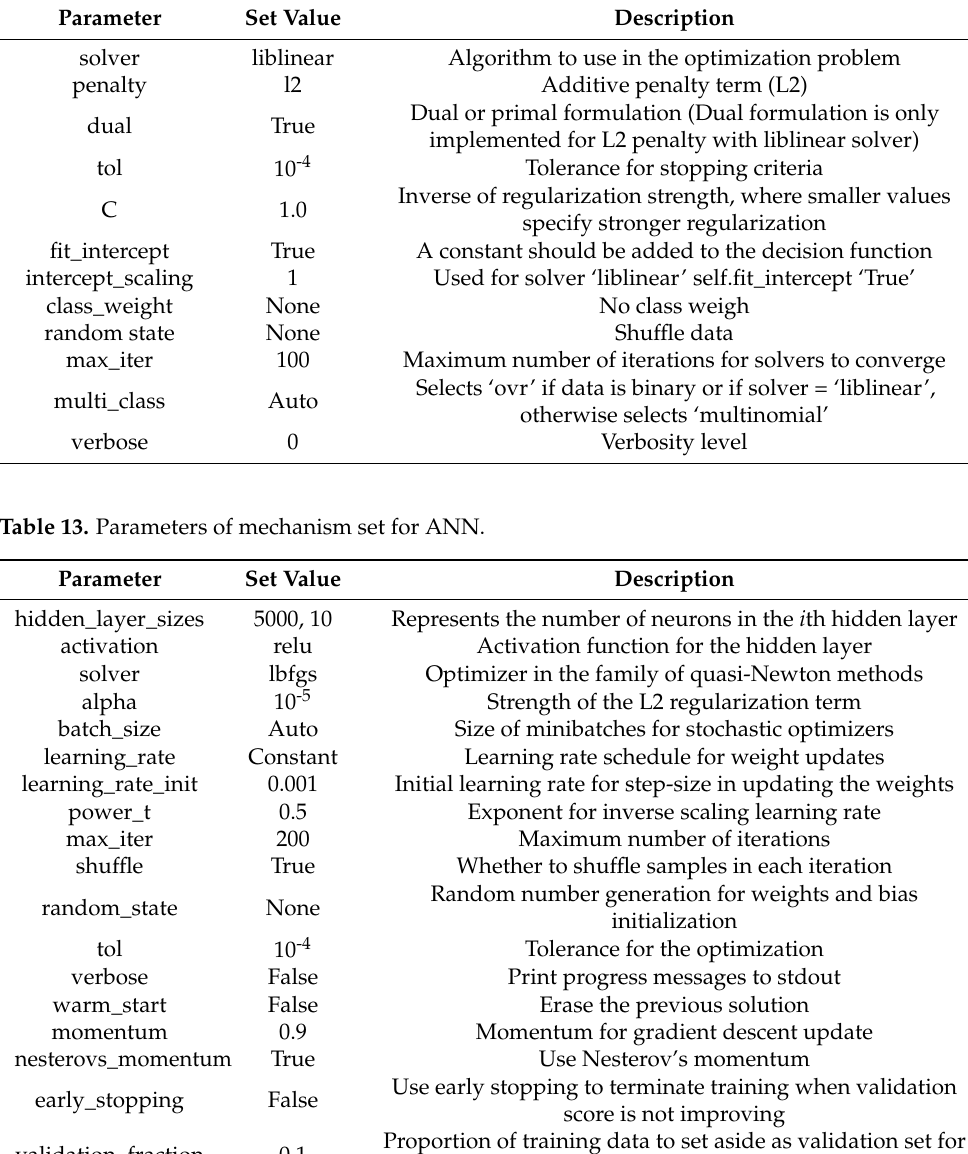
Table 12. Parameters of mechanism set for LR.